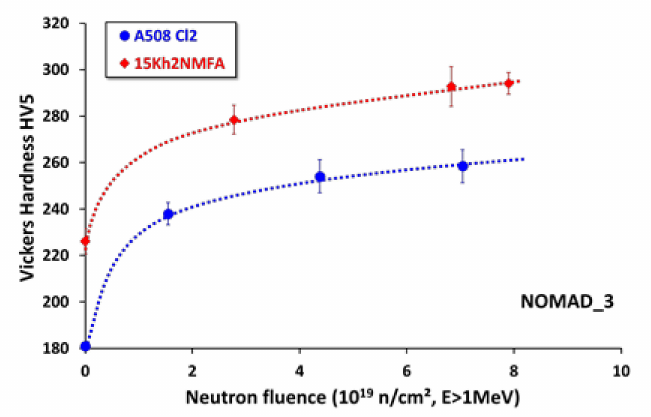
Figure 9. Vickers hardness (5kgf) for A508 Cl.2 and 15Kh2NMFA. The dashed lines are added to guide the eye.